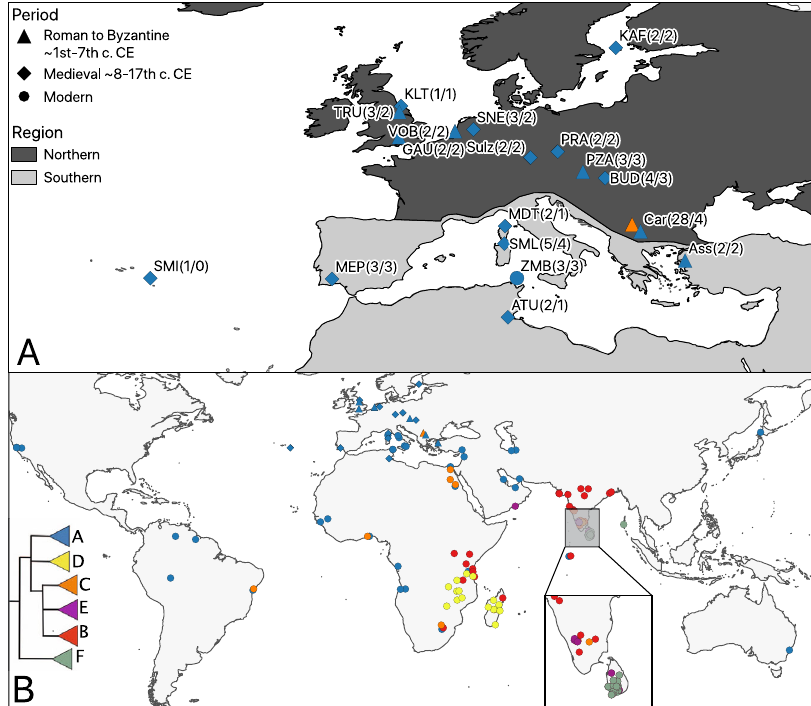
Fig. 2 Sampling sites and mitochondrial phylogeographic patterns. A Map of sampling locations. The numbers in parentheses are numbers of samples included in mitochondrial/nuclear genome analysis. SMI (Villa Franca do Campo), MEP (Mertola), KLT (Kilton Castle), TRU (Tanner Row, York), GAU (Gatehampton Villa), VOB (Voorburg-Forum Hadriani), SNE (Deventer-Stadhuiskwartier), MDT (Monte di Tuda), SML (Santa Maria Lavezzi), ATU (Althiburos), Sulz (Castle Sulzbach), PRA (Prague Castle), PZA (Petronell-Carnuntum Zivilstadt), KAF (Kastelholm), BUD (Buda Castle-Teleki Palace), Car (Cari č in Grad) and Ass (Assos). B The phylogeographic pattern of black rat revealed by CYTB mitochondrial haplogroups (see Supplementary Fig. 4 for detailed phylogeny), including 67 ancient rats, 3 modern rats from Zembra, 132 modern samples from Indian Ocean basin and 274 published samples. Basemap source: ESRI ArcWorld Supplement (World Continents), used under